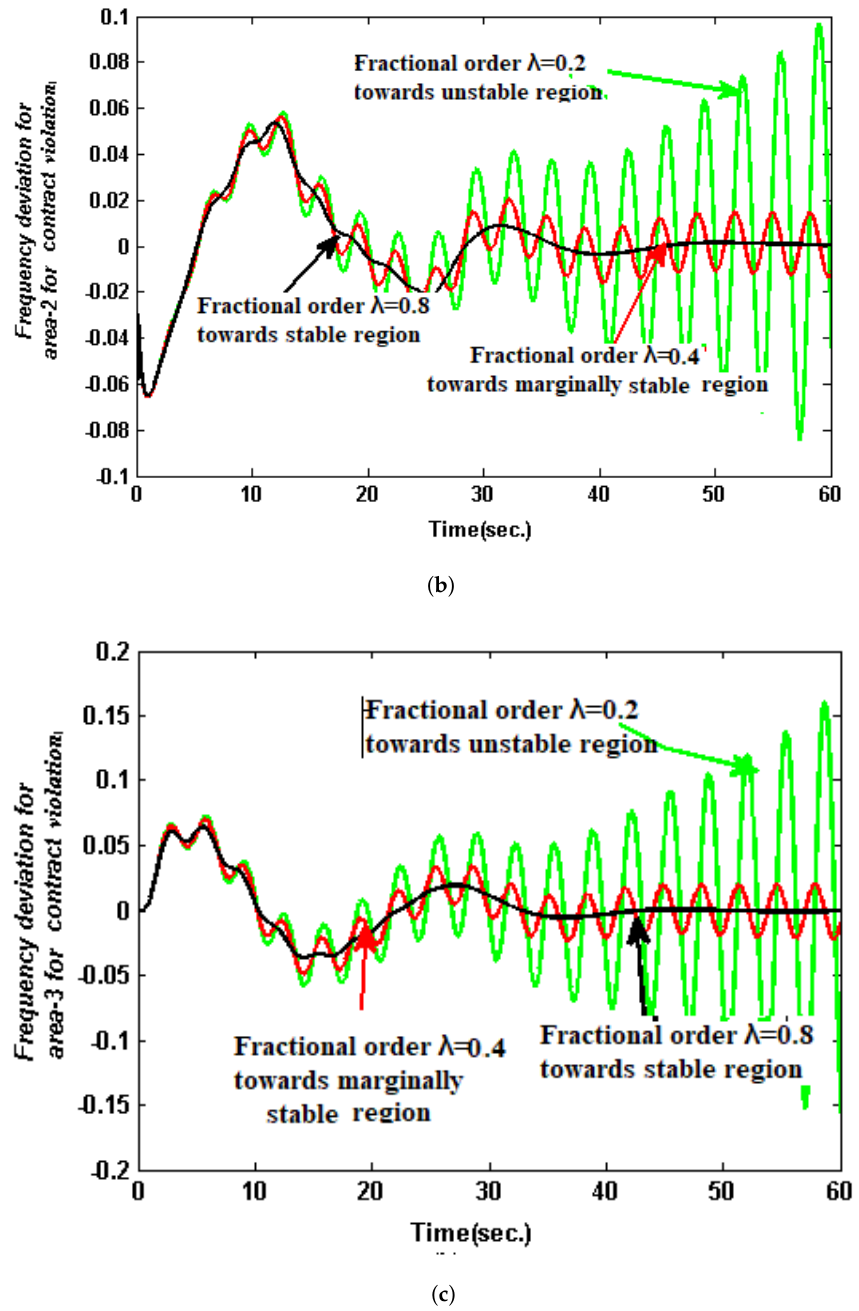
Figure 8. ( a ) Area 1 frequency deviation for contract violation with SLP type load and 10% load disturbance with time − varying delay τ d = 5.231 s at a rate µ = 0. ( b ) Area 2 frequency deviation for contract violation case with SLP type of load and 10% load disturbance with constant time delay τ d = 3.021 s at a rate of µ = 0. ( c ) Frequency deviation of Area 3 with constant time delay τ d = 3.021 s. at a rate µ = 0 at 10% load